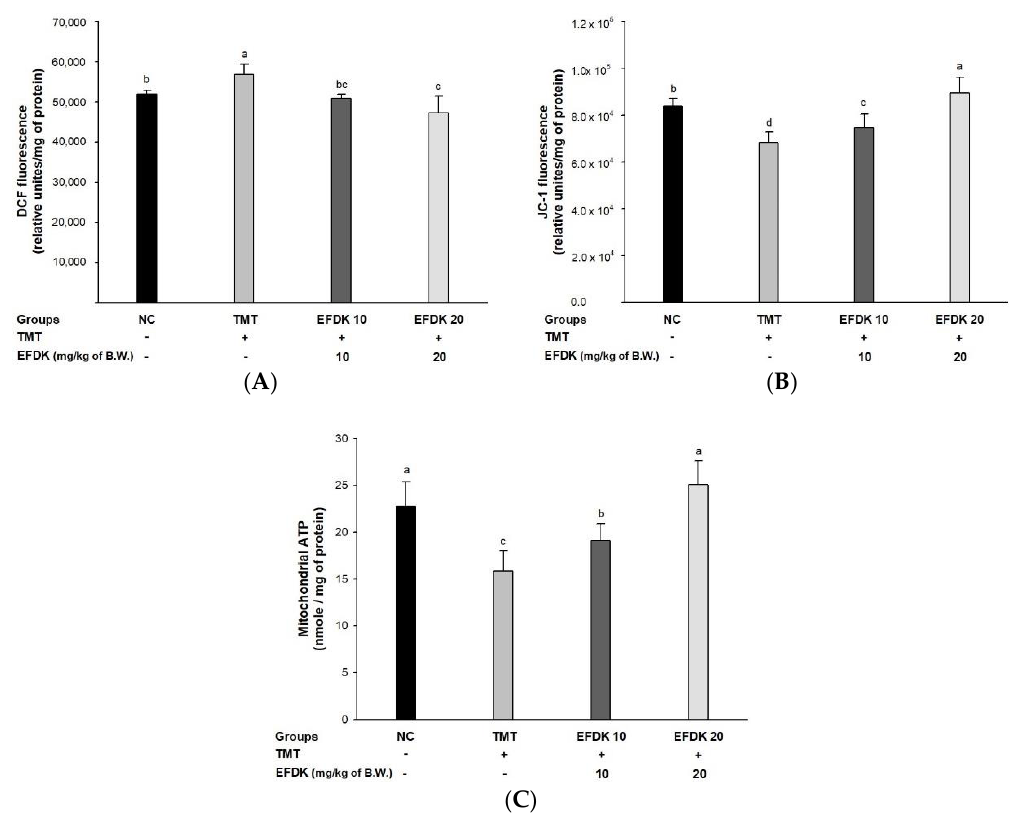
Figure 7. Protective effect of ethyl acetate fraction from persimmon (EFDK) on TMT-induced mitochondrial dysfunction. ( A ) ROS levels; ( B ) MMP levels; ( C ) ATP contents of the mitochondria in mice brain tissues. Results shown are mean ± SD ( n = 5). Data were statistically represented at p < 0.05, and different small alphabets mean statistical significance.